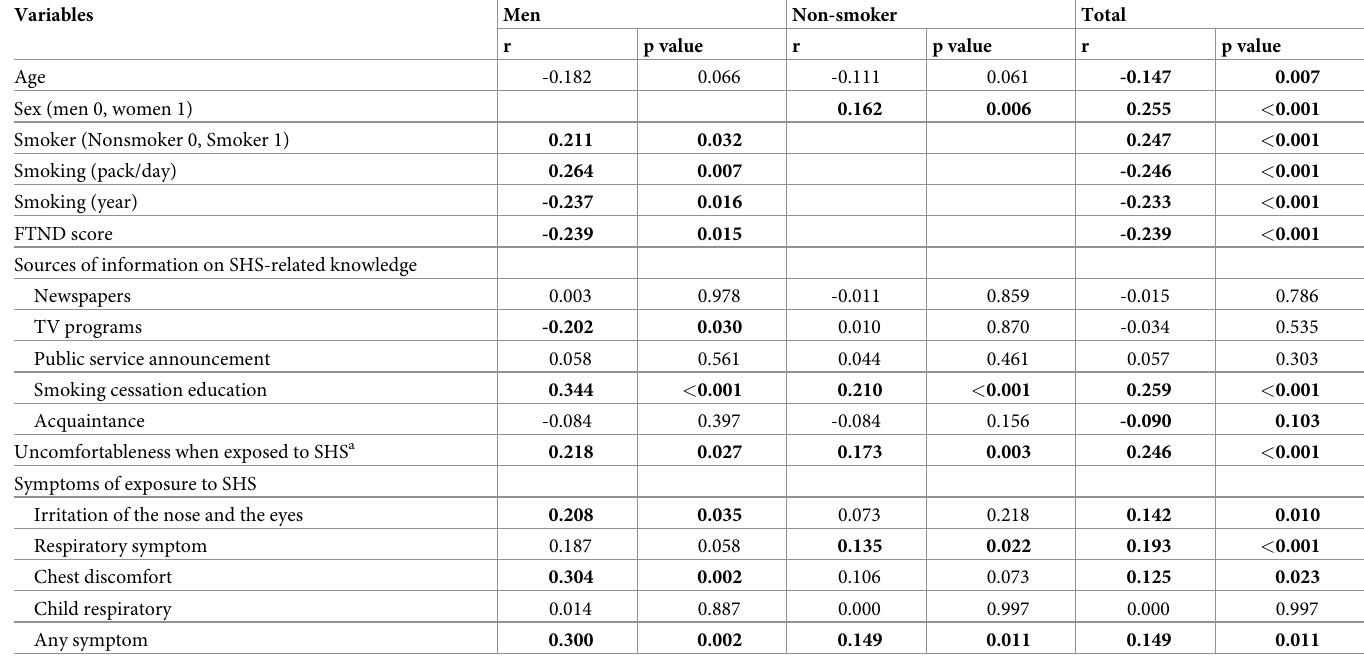
Table 3. Factors related to SHS knowledge.